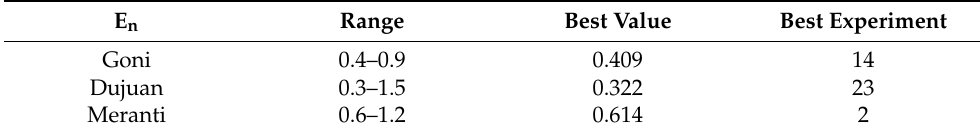
Table 11. E n statistics of the wind direction simulation in the three typhoon